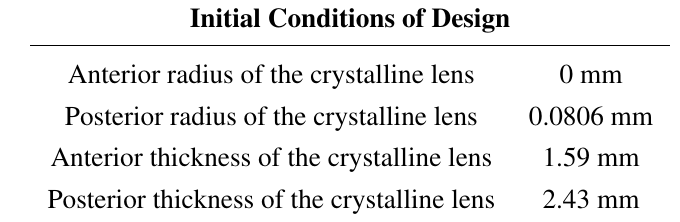
Table 1. Initial specifications of the crystalline lens of the human